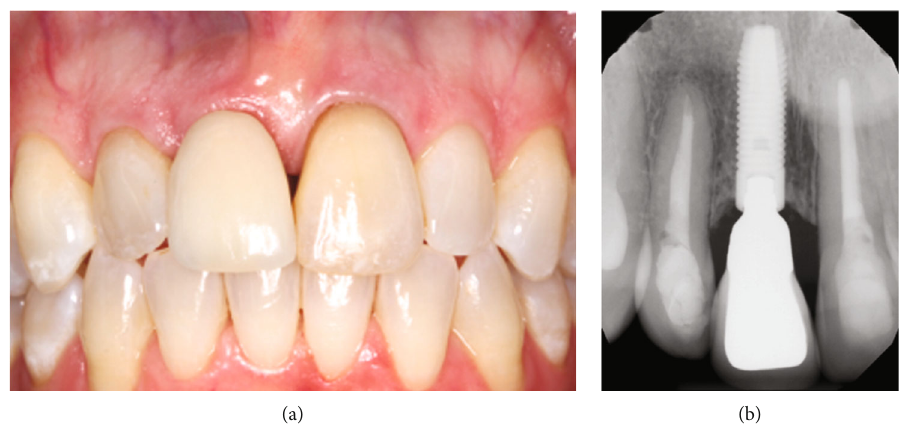
Figure 8: (a) Clinical photo and (b) periapical radiograph of the implant at 6.5 years after